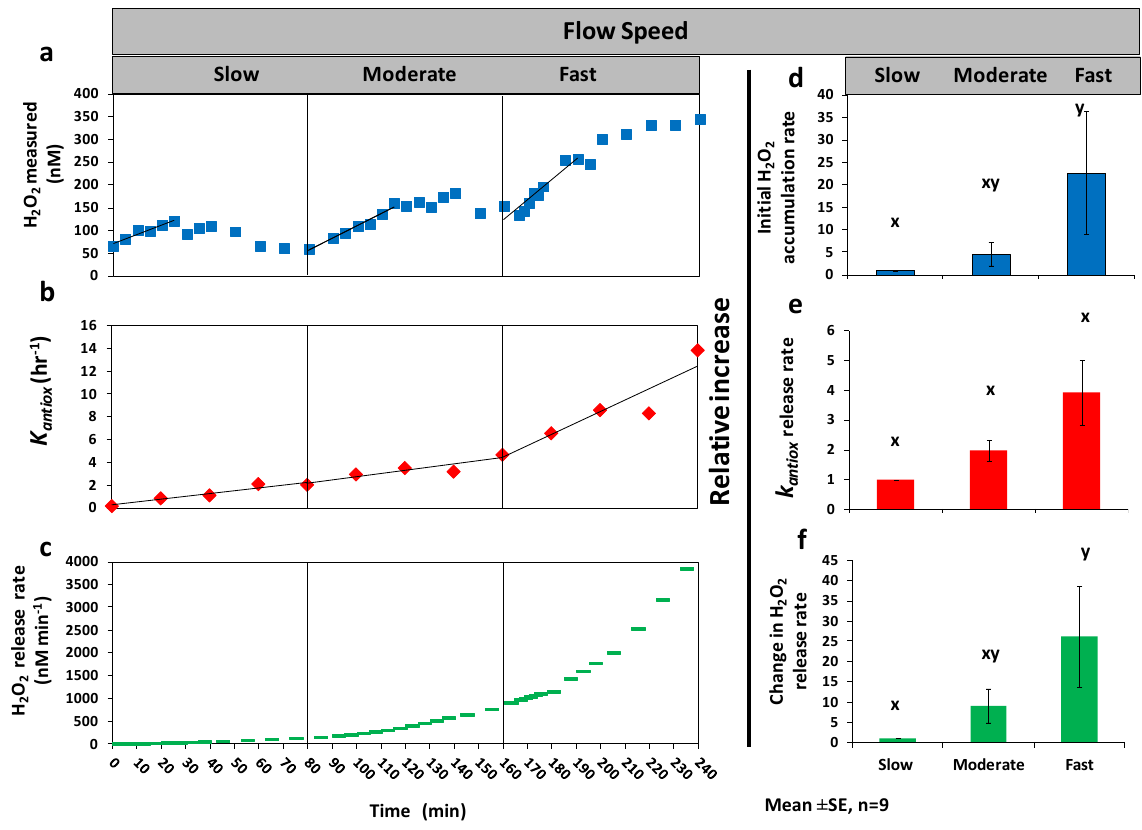
Figure 5. Release of H 2 O 2 and antioxidant activity by S. pistillata at variable stirring speeds. Line plots showing changes with time in measured H 2 O 2 concentrations (a) and antioxidant activity (b) , and calculated H 2 O 2 released (c) and obtained by increasing stirring speeds in an individual experiment. The rate of change in each of the parameters (i.e., the slopes drawn in a–c ) was calculated for every stirring speed. These rates were then expressed relative to those at slow stirring. These relative changes in each parameter were averaged among all nine experiments. Bar graphs show averaged relative changes of initial H 2 O 2 accumulation rates (d) , antioxidant activity release (e) , and change in H 2 O 2 release rates (f) . The letters in (d–f) refer to significant differences of p < 0 . 05 between stirring speeds for each of the studied parameters, tested with Tukey’s multiple comparison